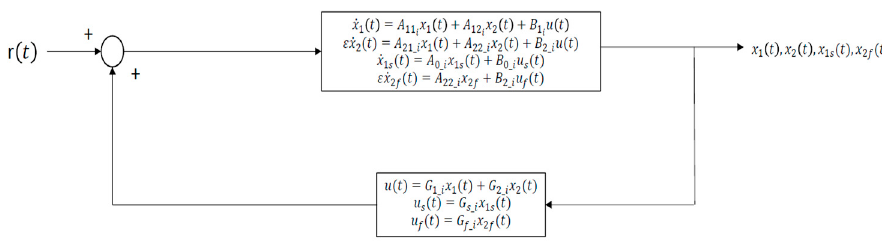
Figure 1. The block diagram of the switched singularly perturbed systems. For the nominal switched linear system